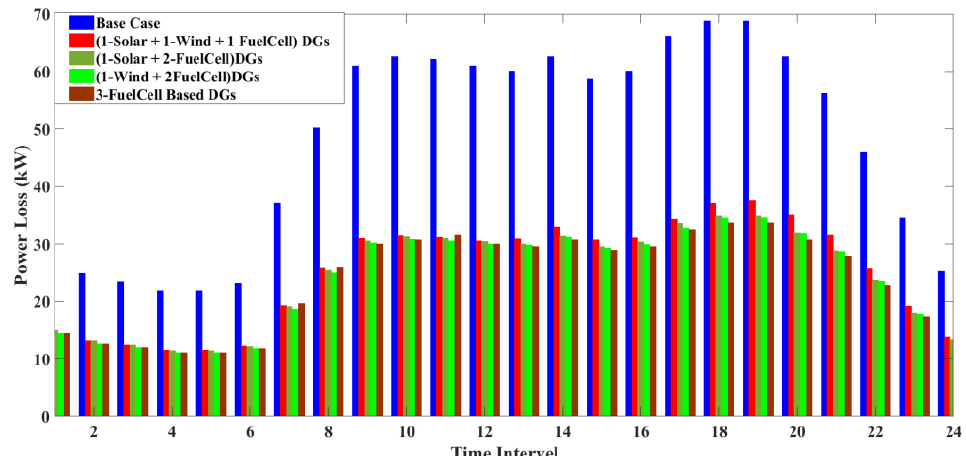
Figure 16. 28 practical test system P Loss typical day with different cases.